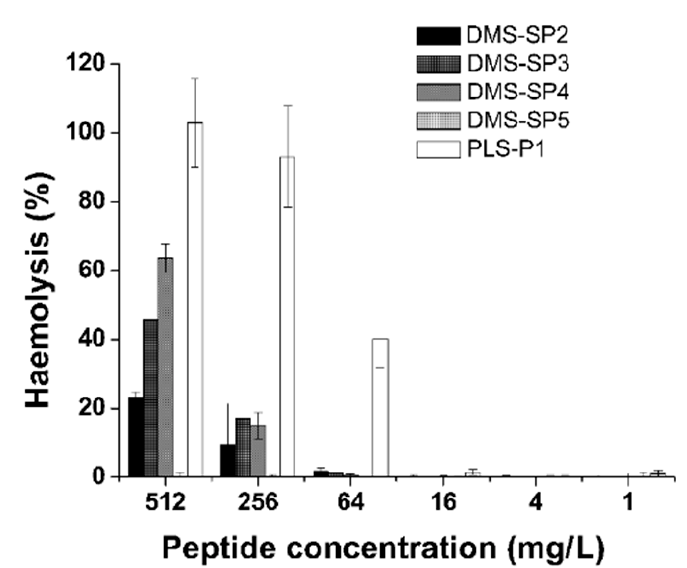
Figure 5. Haemolytic activity of Dermaseptins SP2–SP5 and Phylloseptin SP-1. The total hemolysis (100%) was determined using Triton X-100.